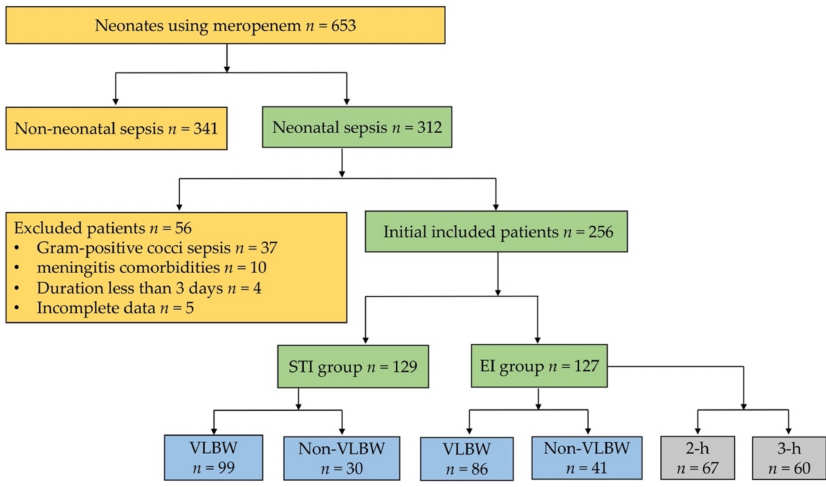
Figure 1. Inclusion and exclusion criteria of participants. Table 1. Baseline information of the patients finally included in the